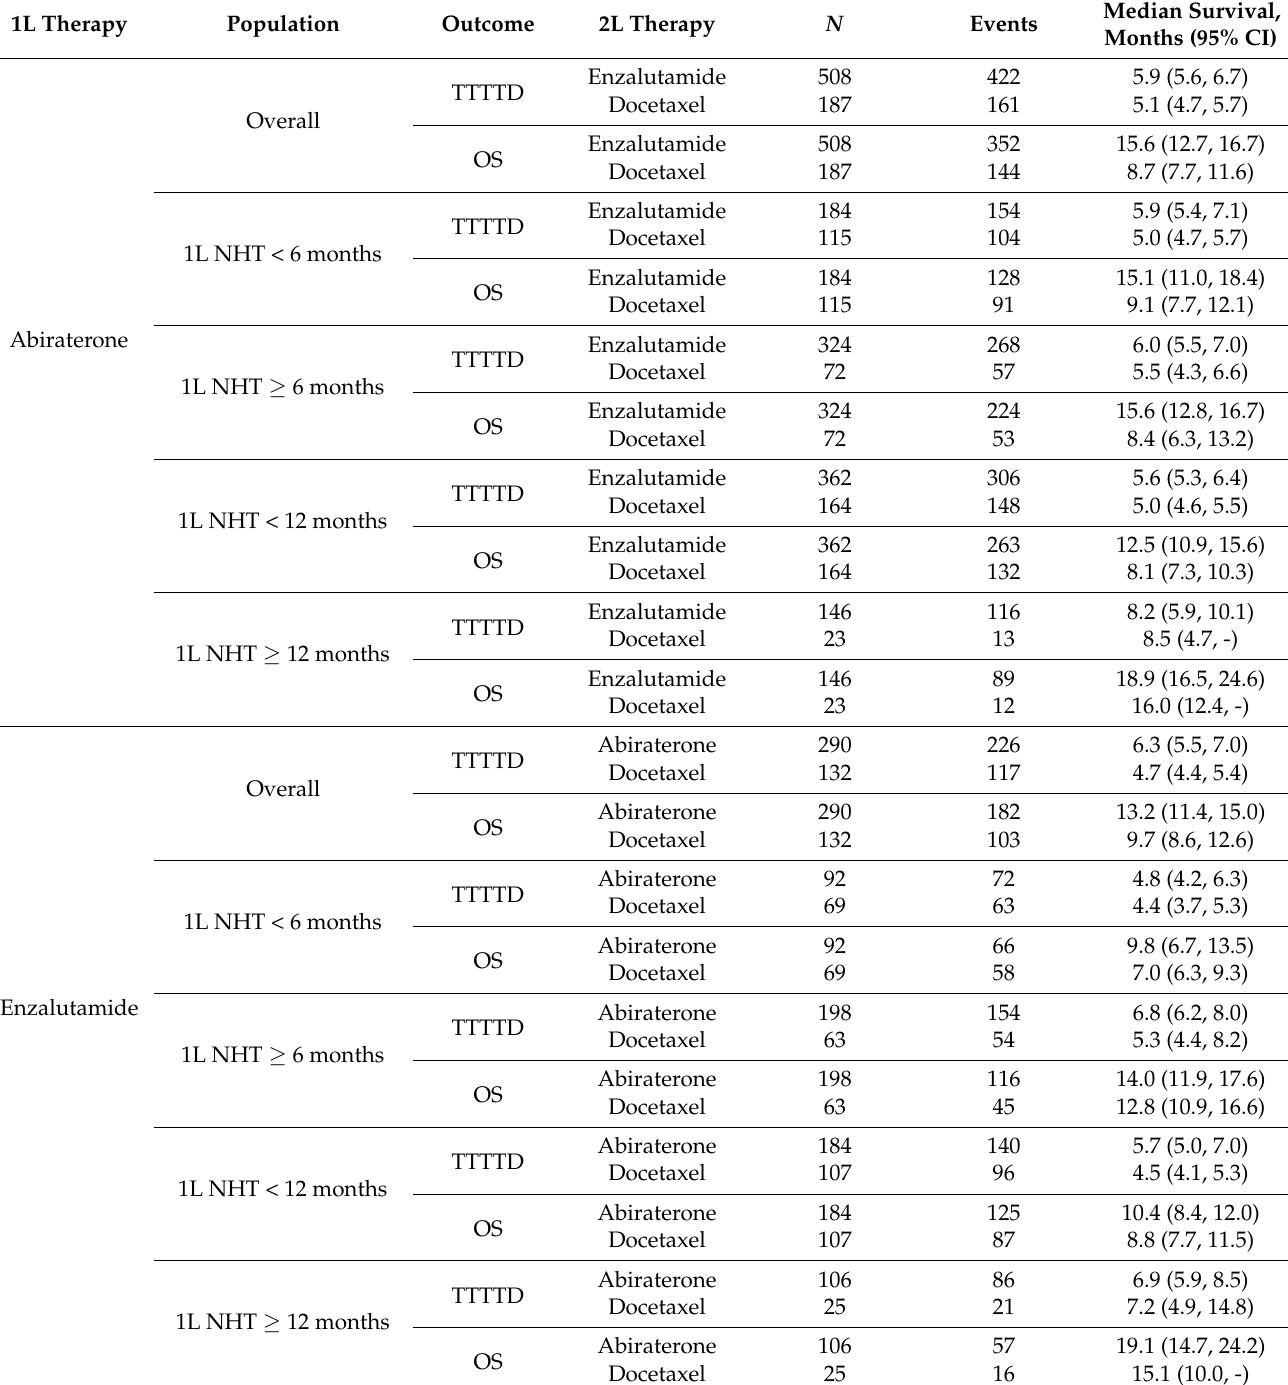
Table 1. Median TTTTD and OS times, starting from the initiation of second-line (2L) therapy, overall and in subgroups defined by time on first-line (1L) therapy. Median survival estimates and 95% confidence intervals (CIs) are estimated using the Kaplan–Meier method, and are not adjusted for any covariates. Confidence limits that could not be estimated due to limited sample size are denoted by “-”. TTTTD is time to third-line treatment or death, and OS is overall